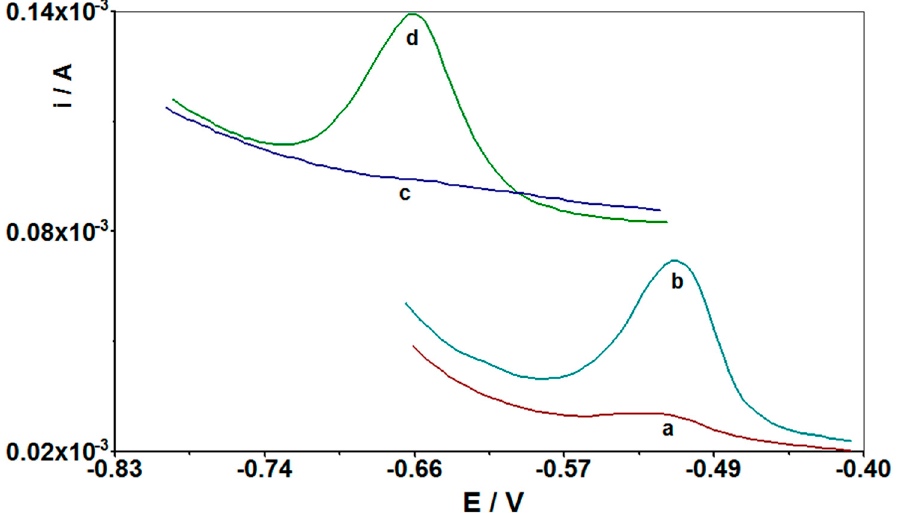
Figure 11. Comparison of differential pulse voltammograms obtained in the course of Cd(II) determination at the electrode CuF/GCE ( a , b ) and CuF/CN/SPE ( b , c ): ( a ) background for CuF/GCE; ( b ) as ( a ) + 1 × 10 − 7 M Cd(II); ( c ) background for CuF/CN/SPE; and ( d ) as ( c ) + 1 × 10 − 7 M Cd(II). Accumulation potential and time for CuF/GCE was − 0.7 V and 210 s; accumulation potential and time for CuF/CN/SPE was − 0.75 V and 210 s.